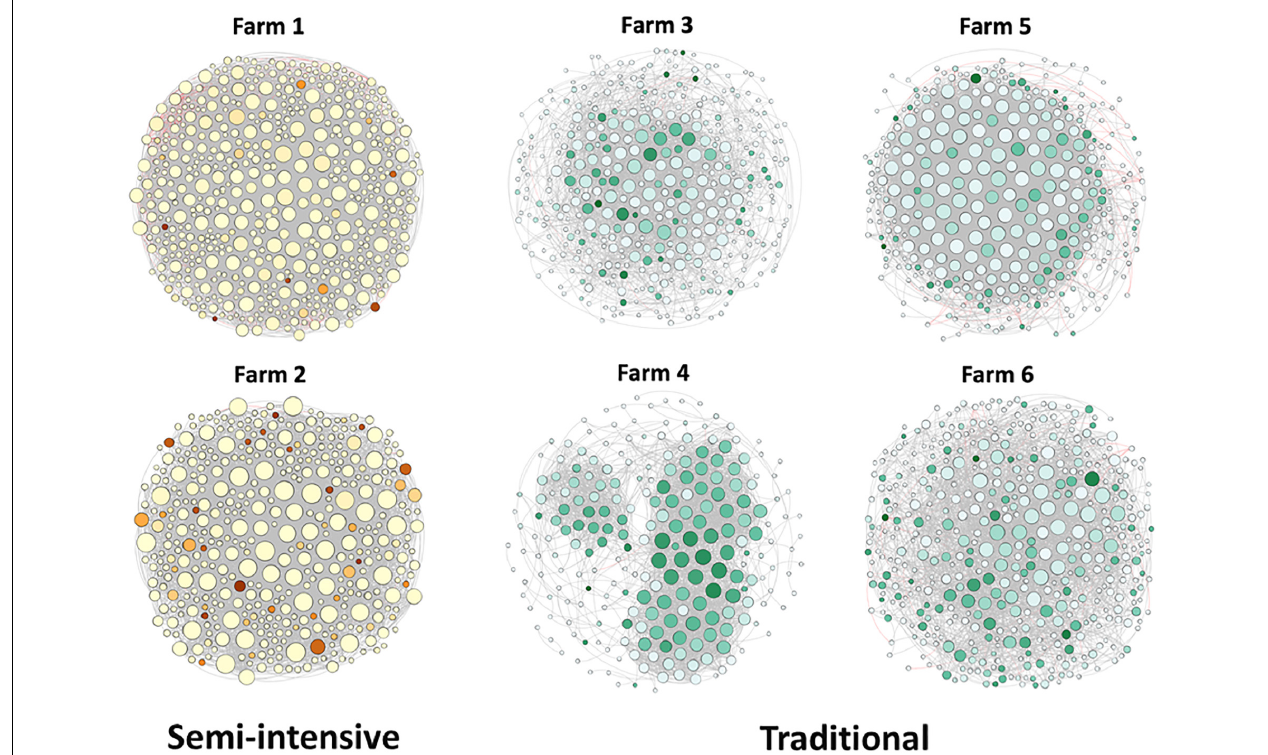
FIGURE 7 | Network co-occurrence analysis of microbial communities in beef cattle feces from semi-intensive and traditional management system farms. Each node represents taxa affiliated at genus level (based on shotgun), and the size of node is proportional to the number of connections, i.e., degree. Each node was labeled at phylum